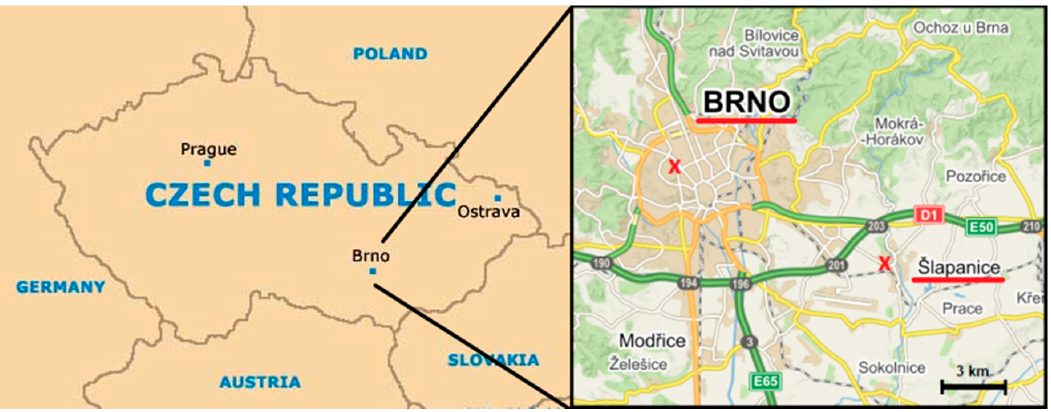
Figure 1. Location of sampling sites (Brno and Šlapanice) on a map of the Czech Republic.